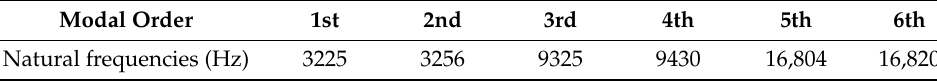
Table 2. The first six natural frequencies of the stator.